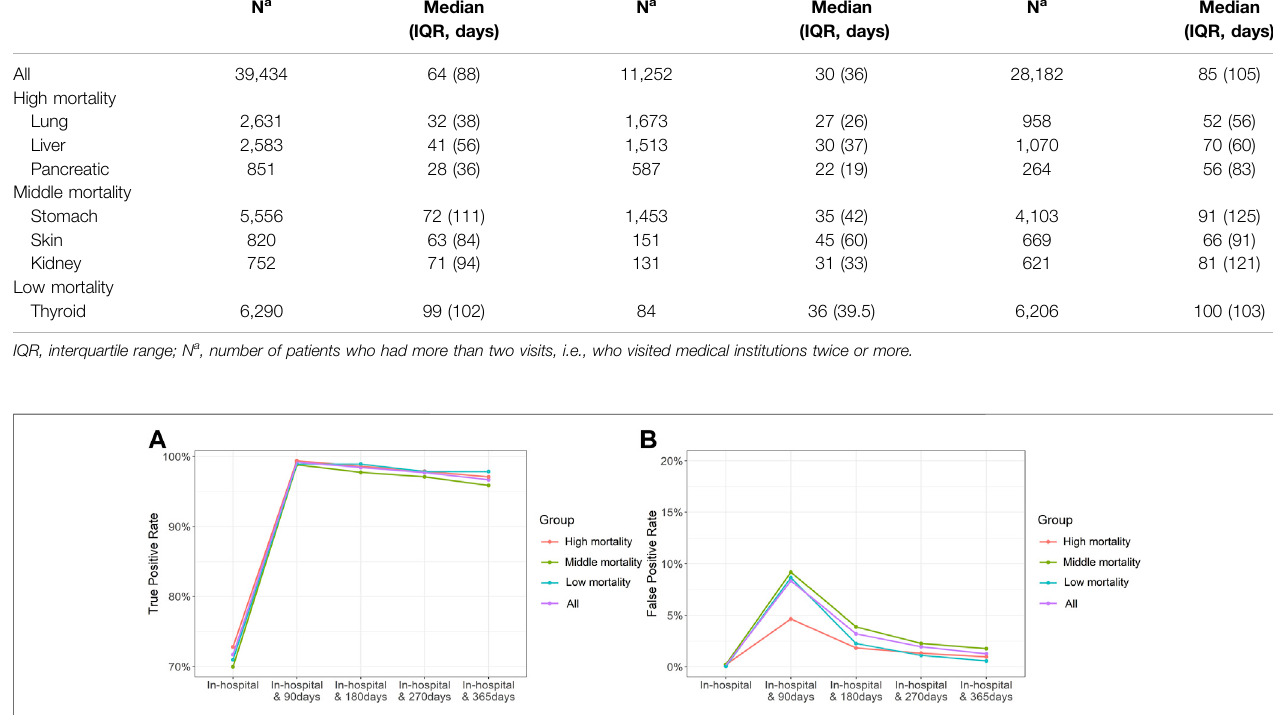
Frontiers in Pharmacology |